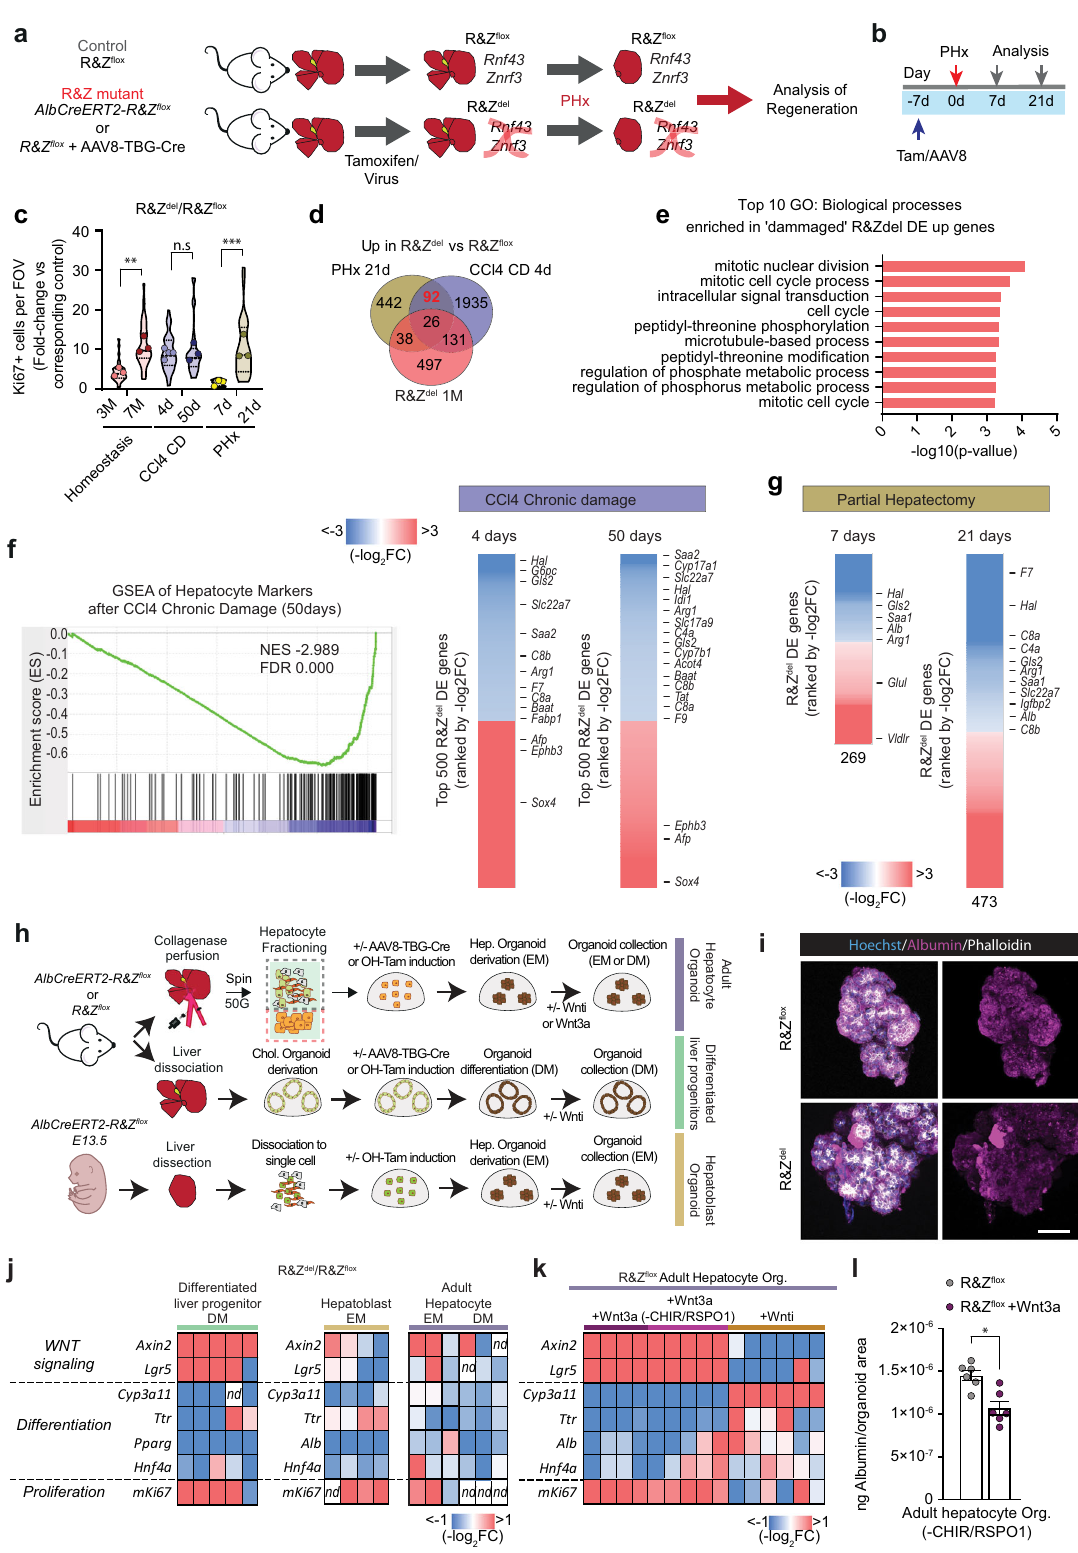
Top 10 GO: Biological processes enriched in 'dammaged' R&Zdel DE up